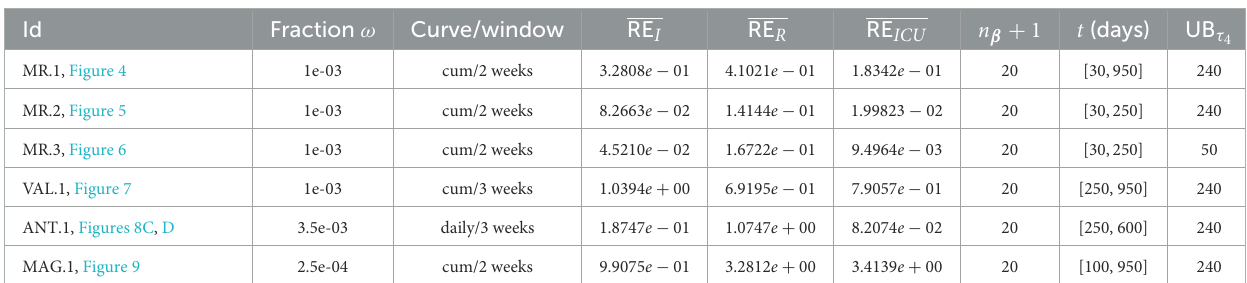
Table 2 Model results for different ω